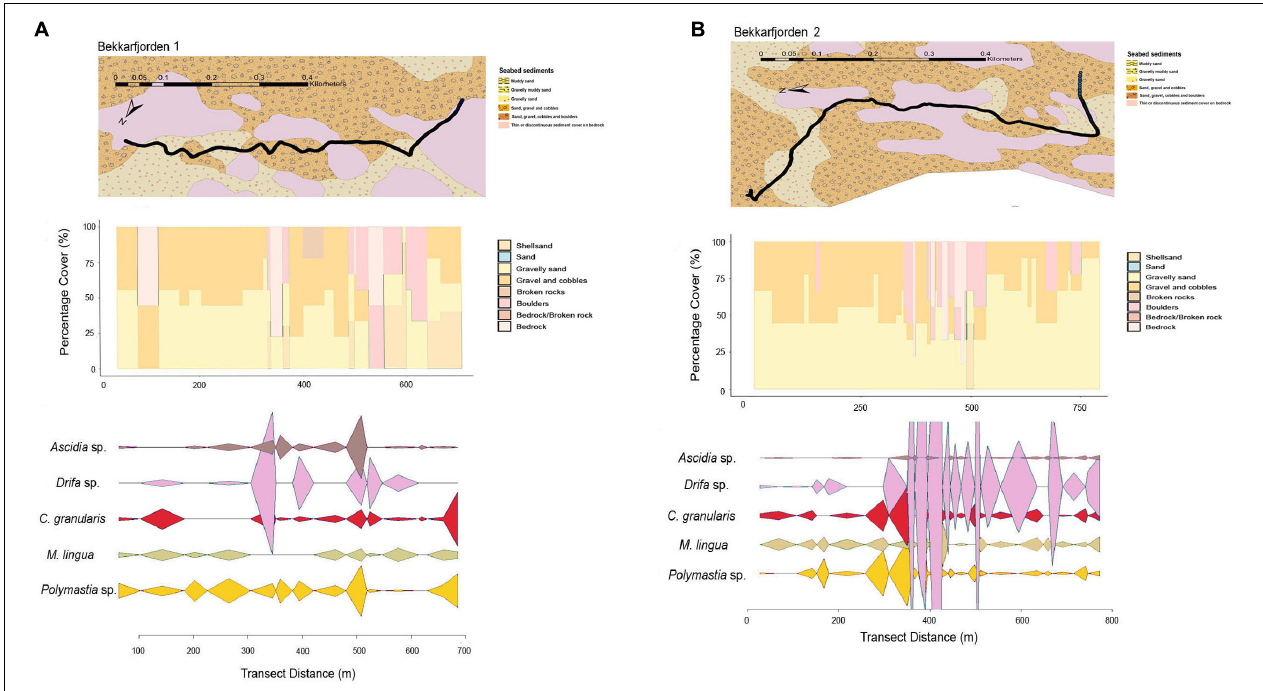
FIGURE 4 | Mixed-substrate seabed characteristics, sequential bar plots of the percentage coverage of the primary substrate types from the camera transects and densities of key epifaunal species or genus at the transect sites in (A) Bekkarfjorden 1 and (B) Bekkarfjorden 2.